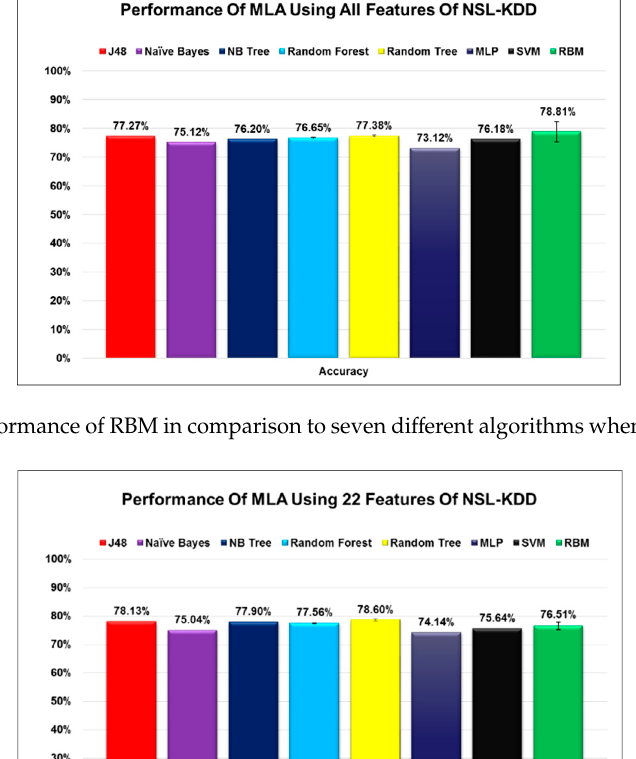
Figure 5. The performance of RBM in comparison to seven different algorithms when using 12 features. Examining the figures, we could perceive that using the infoGain algorithm during the process of feature selection enabled us to extract the most important features with minimal changes to the accuracy for most algorithms, and in some cases with a slight increase in the accuracy. The change in the accuracy of each algorithm when certain features were selected was below 2% for most of the cases and never exceeded 3%. From our previous analysis, it is obvious that these algorithms can act as a classifier for A-NIDS using the network packet analysis. To get a more in-depth analysis of the suitability of RBM as a model for A-NIDS we refer the reader to our previous research study on the subject [51]. The minor change in accuracy when choosing only a specific number of features can have a drastic effect on the reduction of the size of the datasets as well as the complexity associated with the large number of features especially when we are building machine learning models that act as classifiers for A-NIDS. One more thing we would like to emphasize is the fact that these sets of features do not represent the optimal features to represent the data even though, in theory, they could. More research and studies in this area need to be done to figure out methods and approaches to assess whether those selected features are the best representation of a dataset or if there is even an alternative group of selected features that can give us better results. This alternative solution, if it exists, can even surpass the accuracy of all the features in the dataset since they do not contain any additional unnecessary features and as such can result in higher accuracy. 9. Conclusions In this paper, we confirmed the effect of appropriate feature selection on the performance of various machine learning algorithms. We used the NSL-KDD a dataset that is used to evaluate the